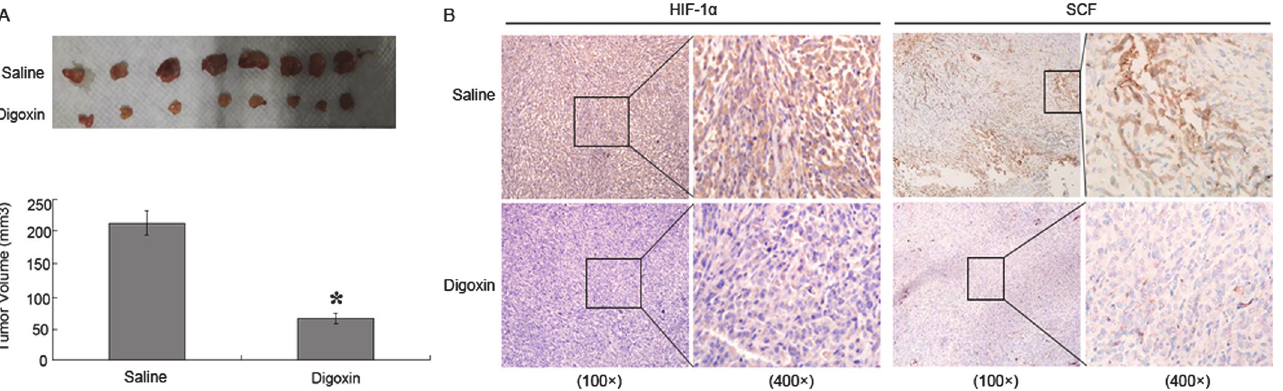
Fig 6. Inhibiting effect of digoxin against PDAC in vivo. (A): The mice tumors ’ volume in different groups. After six weeks of treatment, digoxin therapy decreased the tumors ’ volume, which was significantly smaller than those in the saline control group (p < 0.05). (B): IHC results in different groups. Additionally, the IHC results confirmed the effect of digoxin: Digoxin therapy decreased the HIF-l α and SCF positive tumor cells compared to the saline control group, respectively.